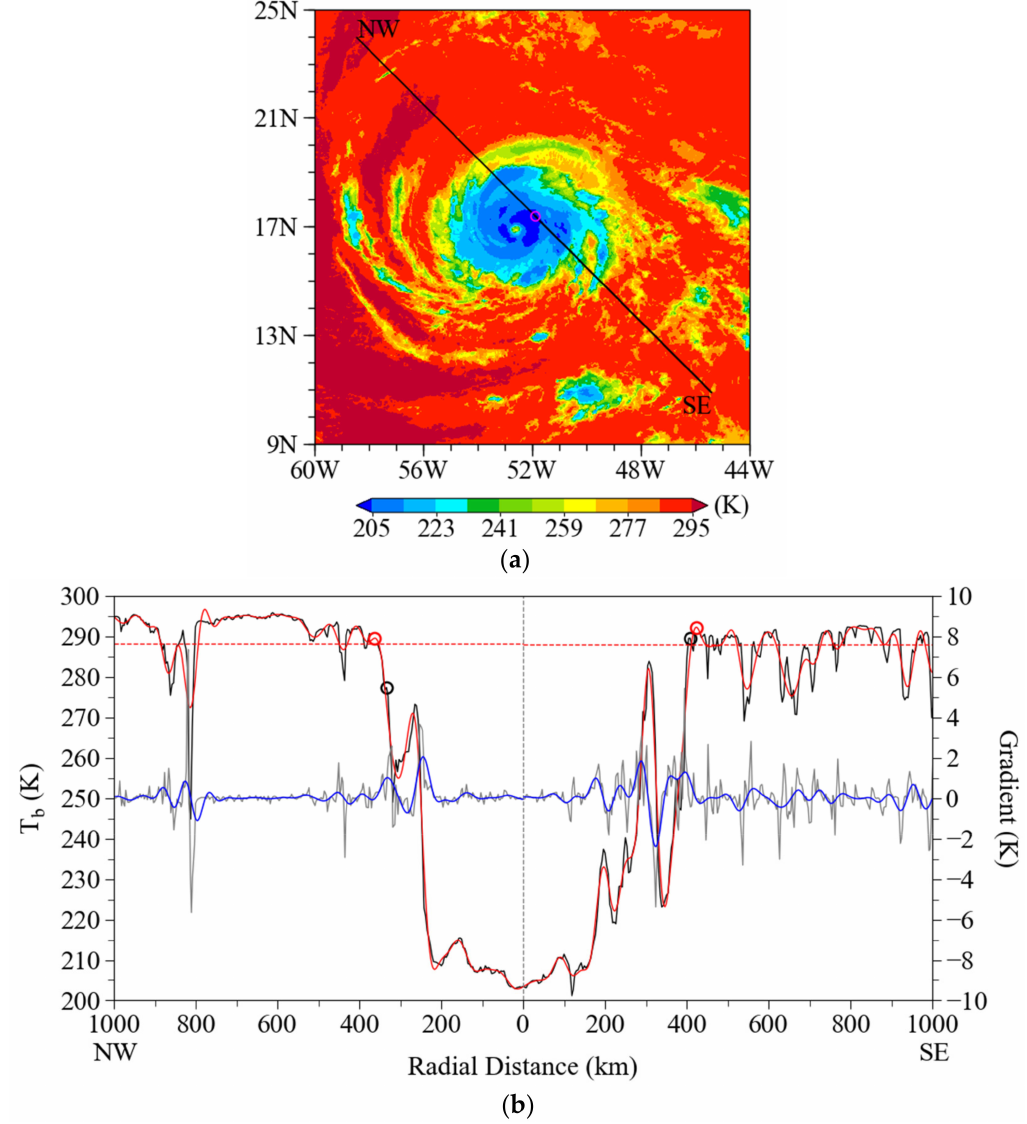
Figure 2. ( a ) Spatial distribution of ABI channel-13 brightness temperature (TB) observations (unit: K; color shading) within and around Irma at about 1200 UTC September 4, 2017 and a northwest- southeast (NW-SE) line passing through the first-guess position (magenta open circle) along which the original (black curve) and filtered (red curve) TB observations are shown in ( b ). Also shown in ( b ) are the radial gradients (unit: K) of original (gray curve) and the filtered TB observations (blue curve) along the same NW-SE line. The filtered TB value averaged over 800–1000 km distances from the first-guess position is indicated by a horizontal dashed line in red. The TB value at the boundary of TC cloud area determined by the original and filtered TB observations along the NW-SE line is indicated by black and red open circle,